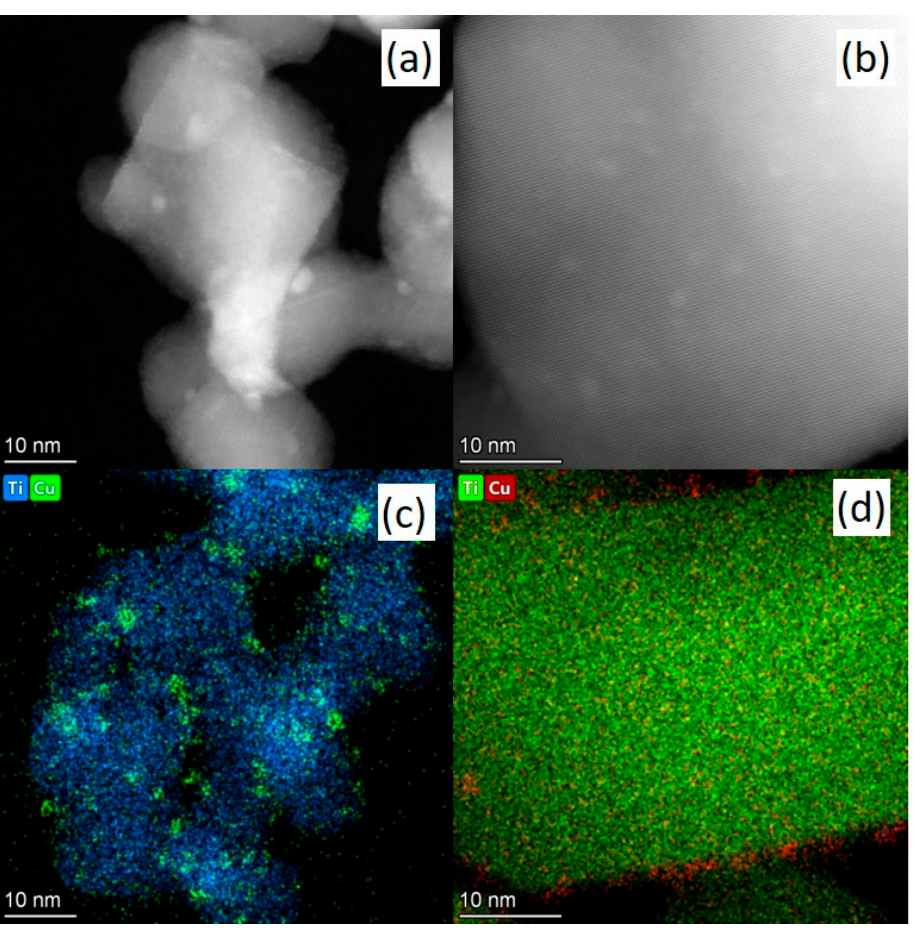
Figure 7. HAADF STEM micrographs of ( a ) CuO x /DTiO 2 and ( b ) CuO x /DTiO 2 T700; EDX mapping of ( c ) CuO x /DTiO 2 and ( d ) CuO x /DTiO 2